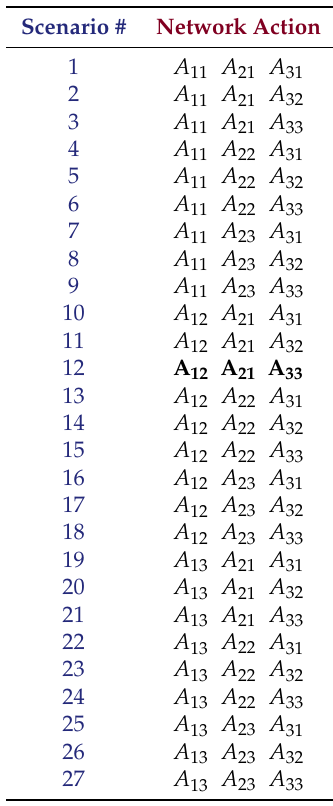
Table 3. All possible Network Actions